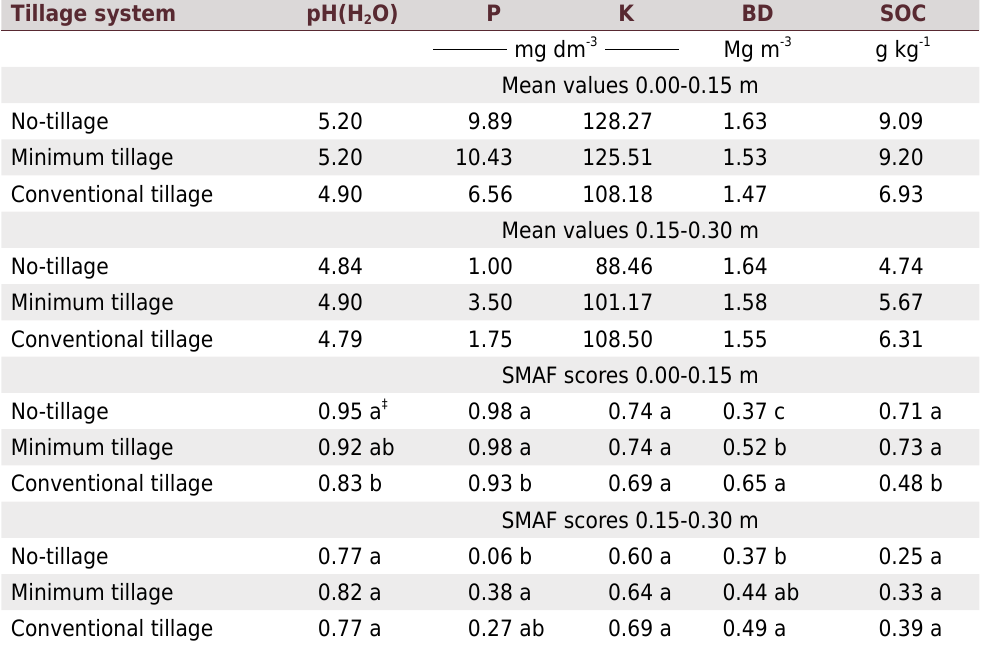
Table 3. Mean values and SMAF scores of soil quality indicators for the 0.00-0.15 and 0.15-0.30 m layers in an area of cassava production under different tillage systems Tillage